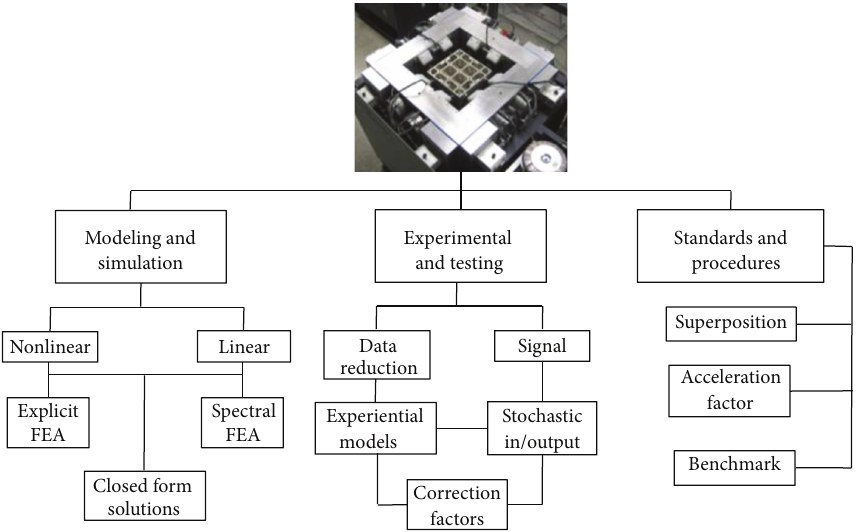
Figure 16: Research areas and potential